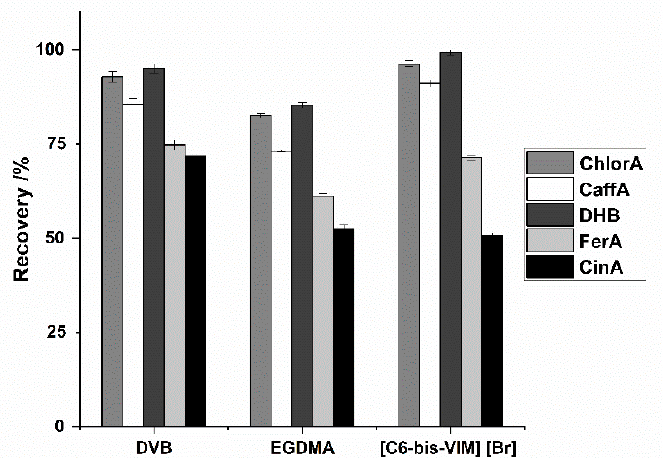
Figure 3. Analyte recovery results obtained from DSPE experiments with three differently crosslinked vinylimidazole polymers. Standard deviations are given as error bars.